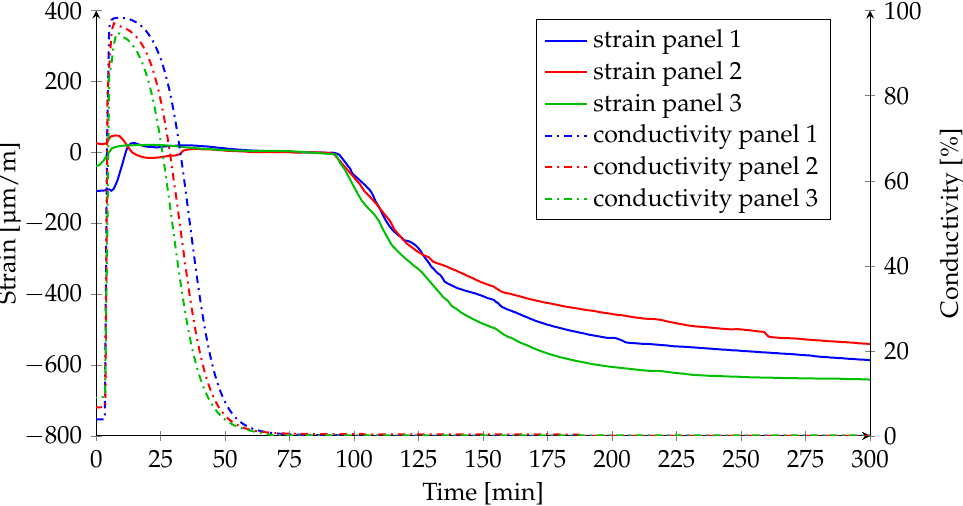
Figure 6. Measured strain of the laminate and conductivity during initial curing of panel 1, panel 2 and panel